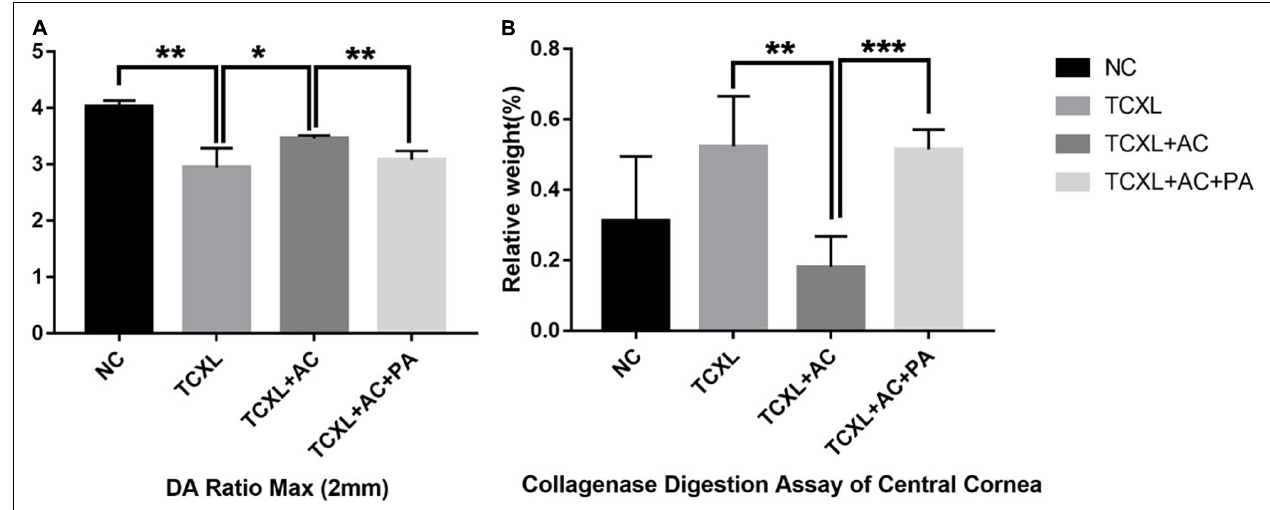
FIGURE 6 | Representative images showing the DA Ratio Max (2 mm) (A) and corneal resistance to collagenase digestion (B) on D28. The DA Ratio Max of the TCXL group was significantly increased when compared with the NC group, while the DA Ratio Max of the TCXL + AC group significantly decreased when compared with the TCXL group. In the collagenase digestion assay, the final relative weight of the cornea in the TCXL group was significantly higher than those in the NC and TCXL + AC groups. Data were presented as mean ± standard deviation ( n = 6; * P < 0.05; ** P < 0.01; *** P <